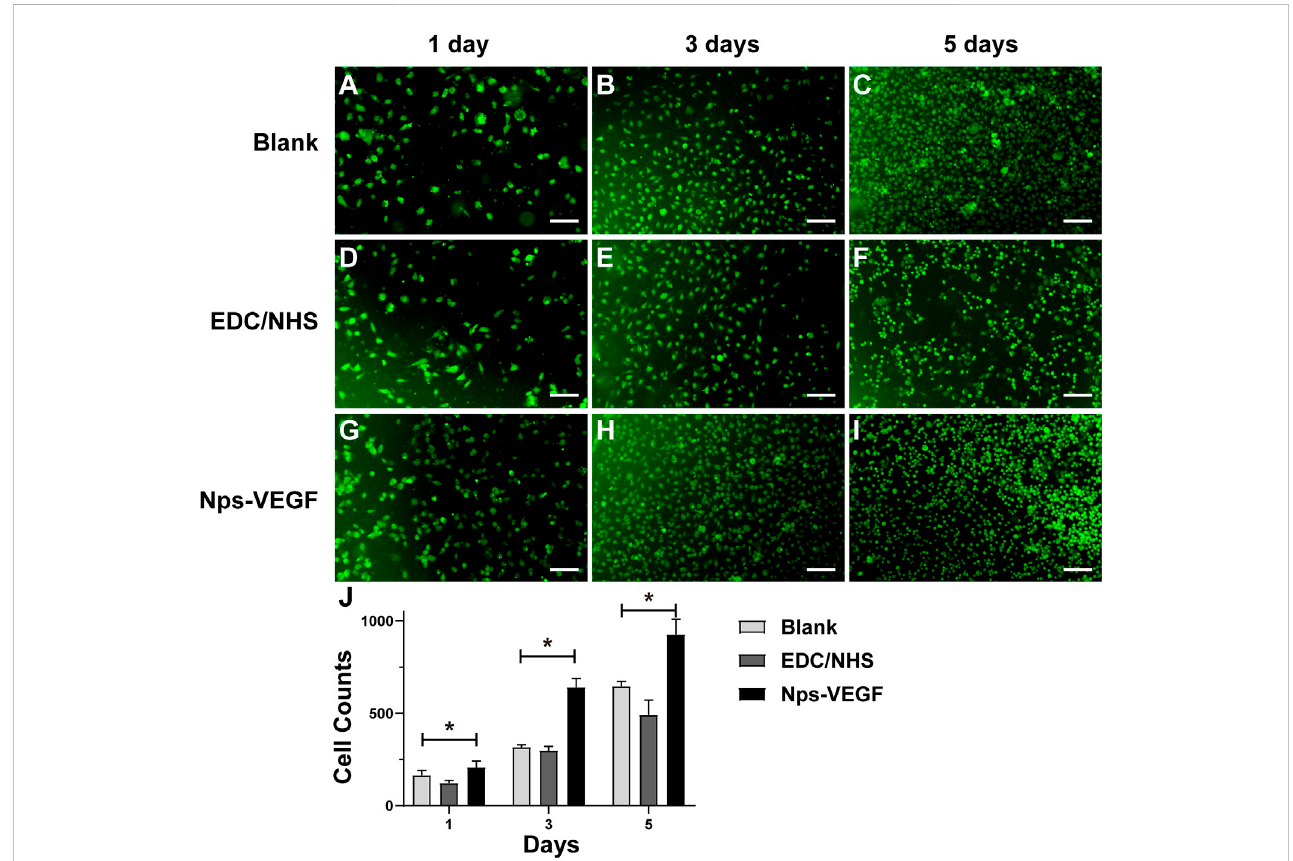
FIGURE 7 The results of HUVECs adhesion and proliferation assay. (A – I) are optical microscope pictures of the three groups on different time points. (J) is the statistical graph of cell counts on day 1, day 3, and day 5 ( n = 6). * indicated statistical difference( p < .05).